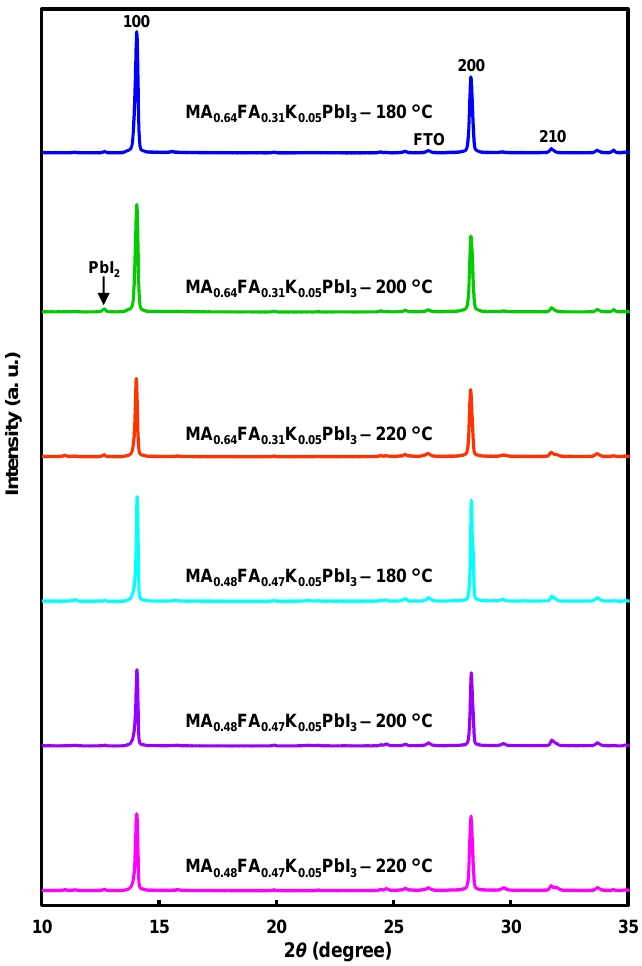
Figure 2. Measured XRD patterns of the present perovskite solar cells.